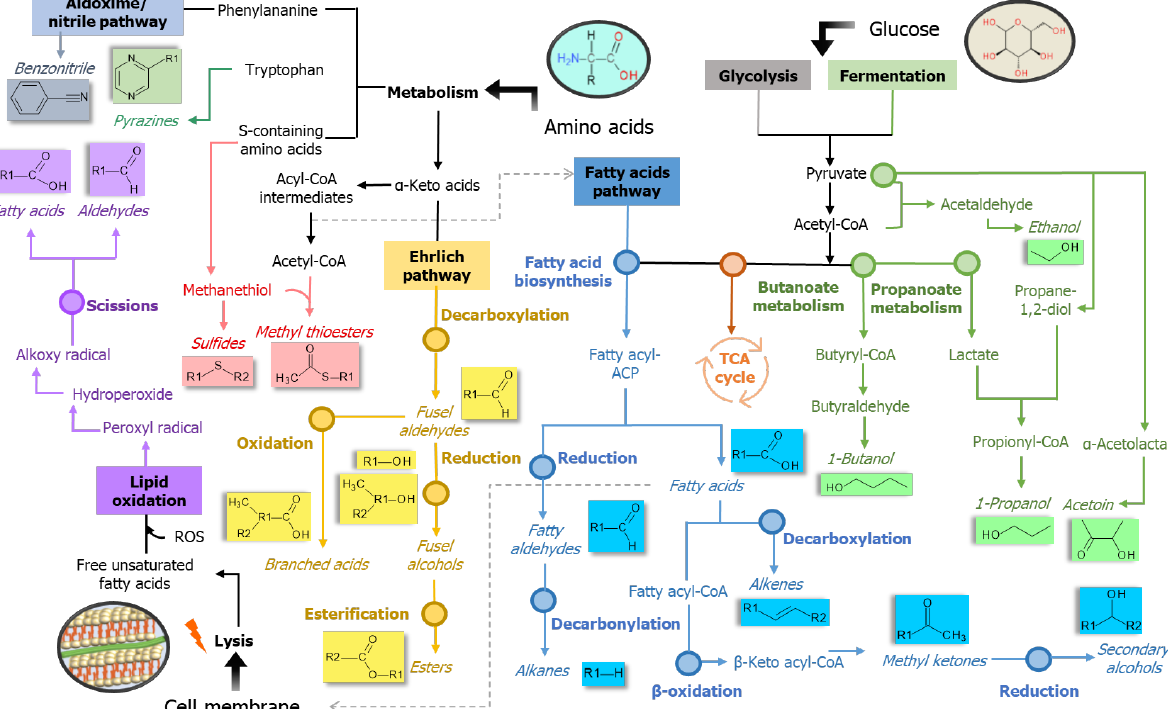
Figure 9. Scheme presenting interconnected bacterial pathways possibly affected by the supplementation of the culture medium with bio-AgNPs. CoA = coenzyme A, TCA = tricarboxylic acid, ACP = acyl carrier protein, S = sulfur, ROS = reactive oxygen species.